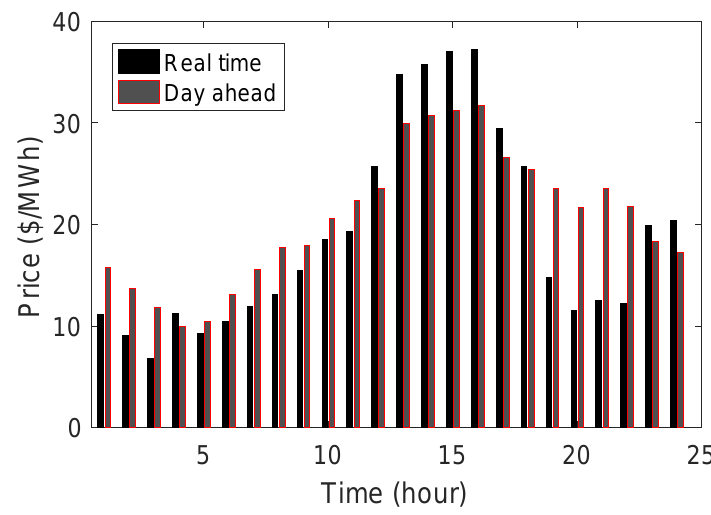
Figure 5. Real-time and day-ahead electricity